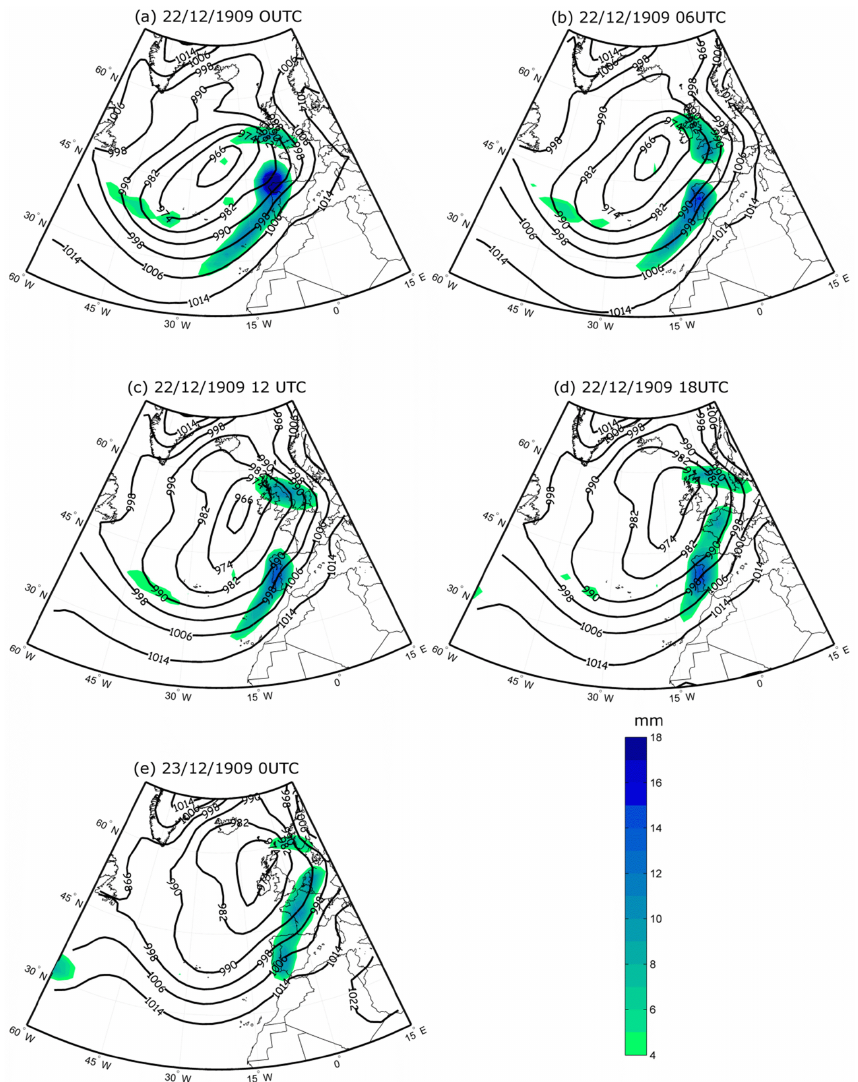
Figure 13. The sea level pressure field (contour, hPa) and 6h accumulated precipitation (shaded, mm) for 22 December 1909 at (a) 00:00UTC, (b) 06:00UTC, (c) 12:00UTC, (d) 18:00UTC, and (e) 23 December at